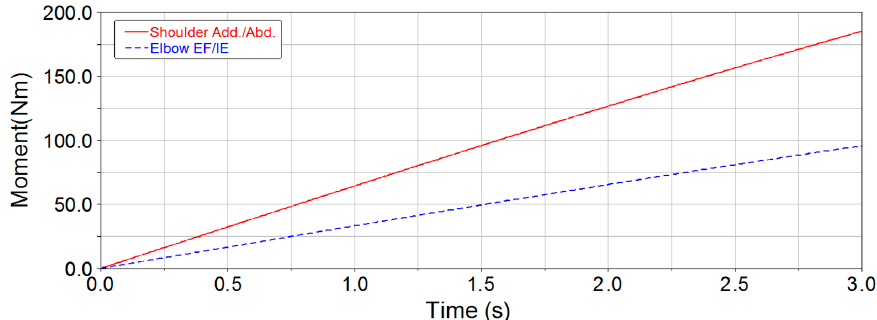
Figure 12. Joint torque curves of lateral lifting for the 3 ‐ DOF exoskeleton.